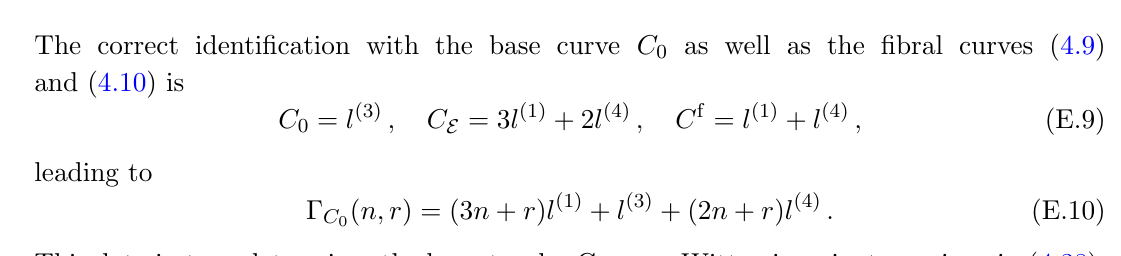
Figure 5 . Maximal charge q max ( n ) per excitation level for Bl 1 P 2 (2 ; 4). The maximally superextremal states form a sublattice of spacing 2 m =